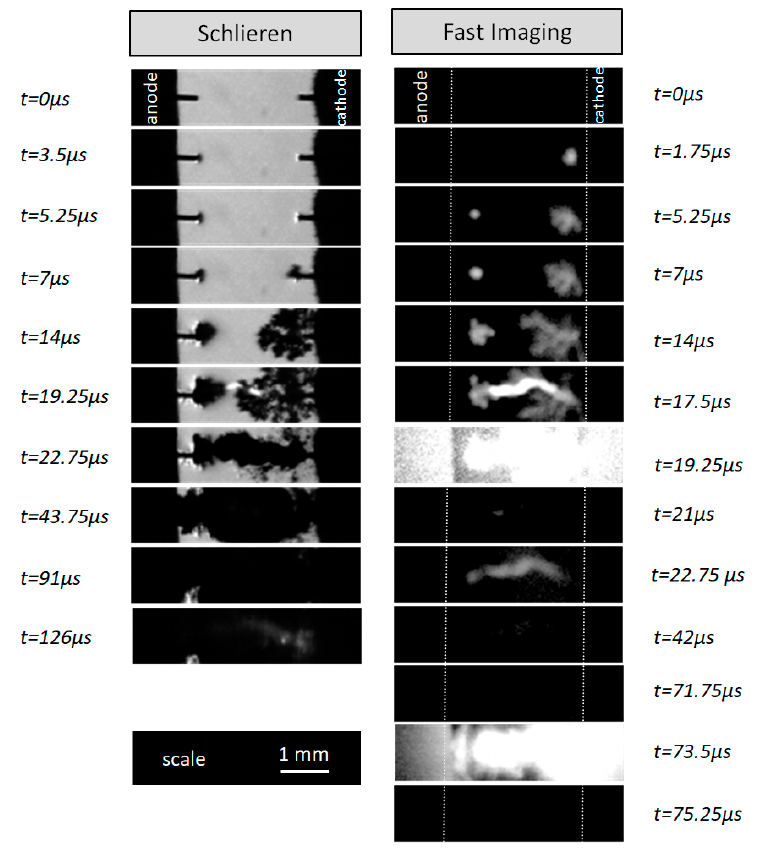
Figure 1. Schlieren imaging and fast imaging obtained for two different experiments representing the cathode regime of electrical breakdown in water using the same initial conditions (U = 12 kV, σ = 100 µS/cm). The corresponding videos are provided as supplementary material.